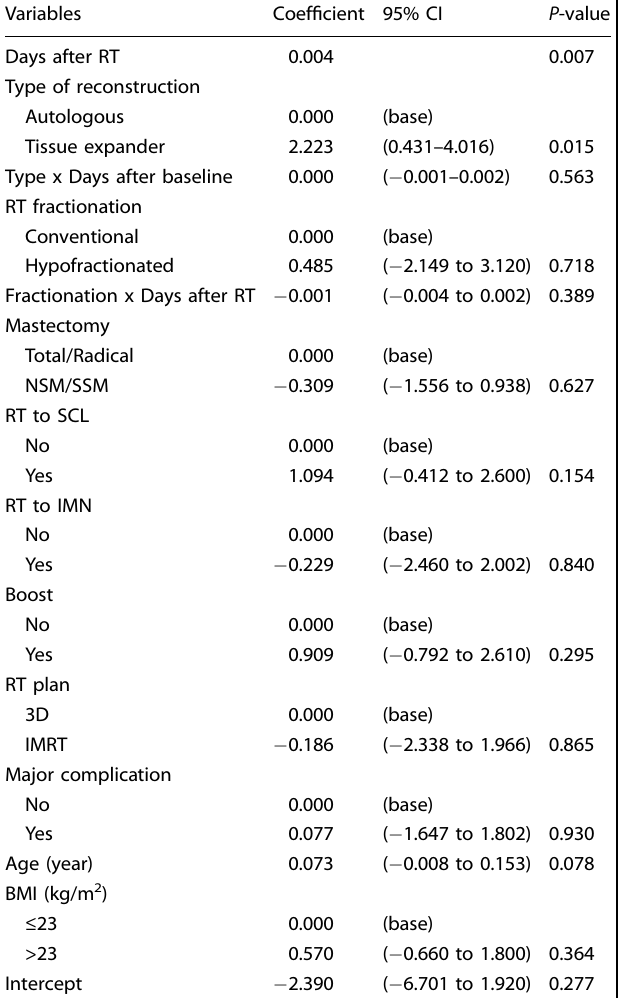
Table 2. Linear mixed model predicting anomaly